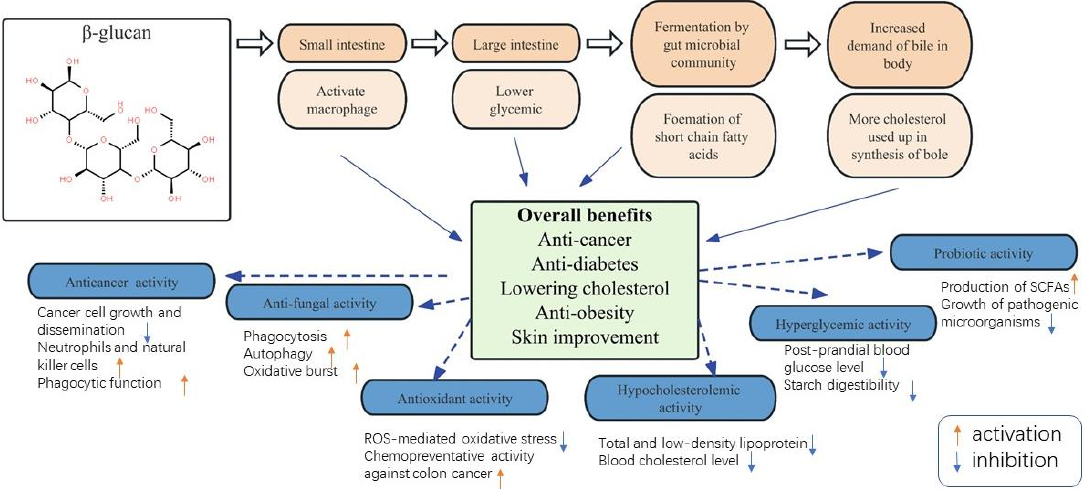
Figure 1. Human health benefits of β-glucan associated with anti-cancer/anti-infection, anti-fungal, antioxidant, hypocholesterolemic, hyperglycemic and probiotic activity [7–10].